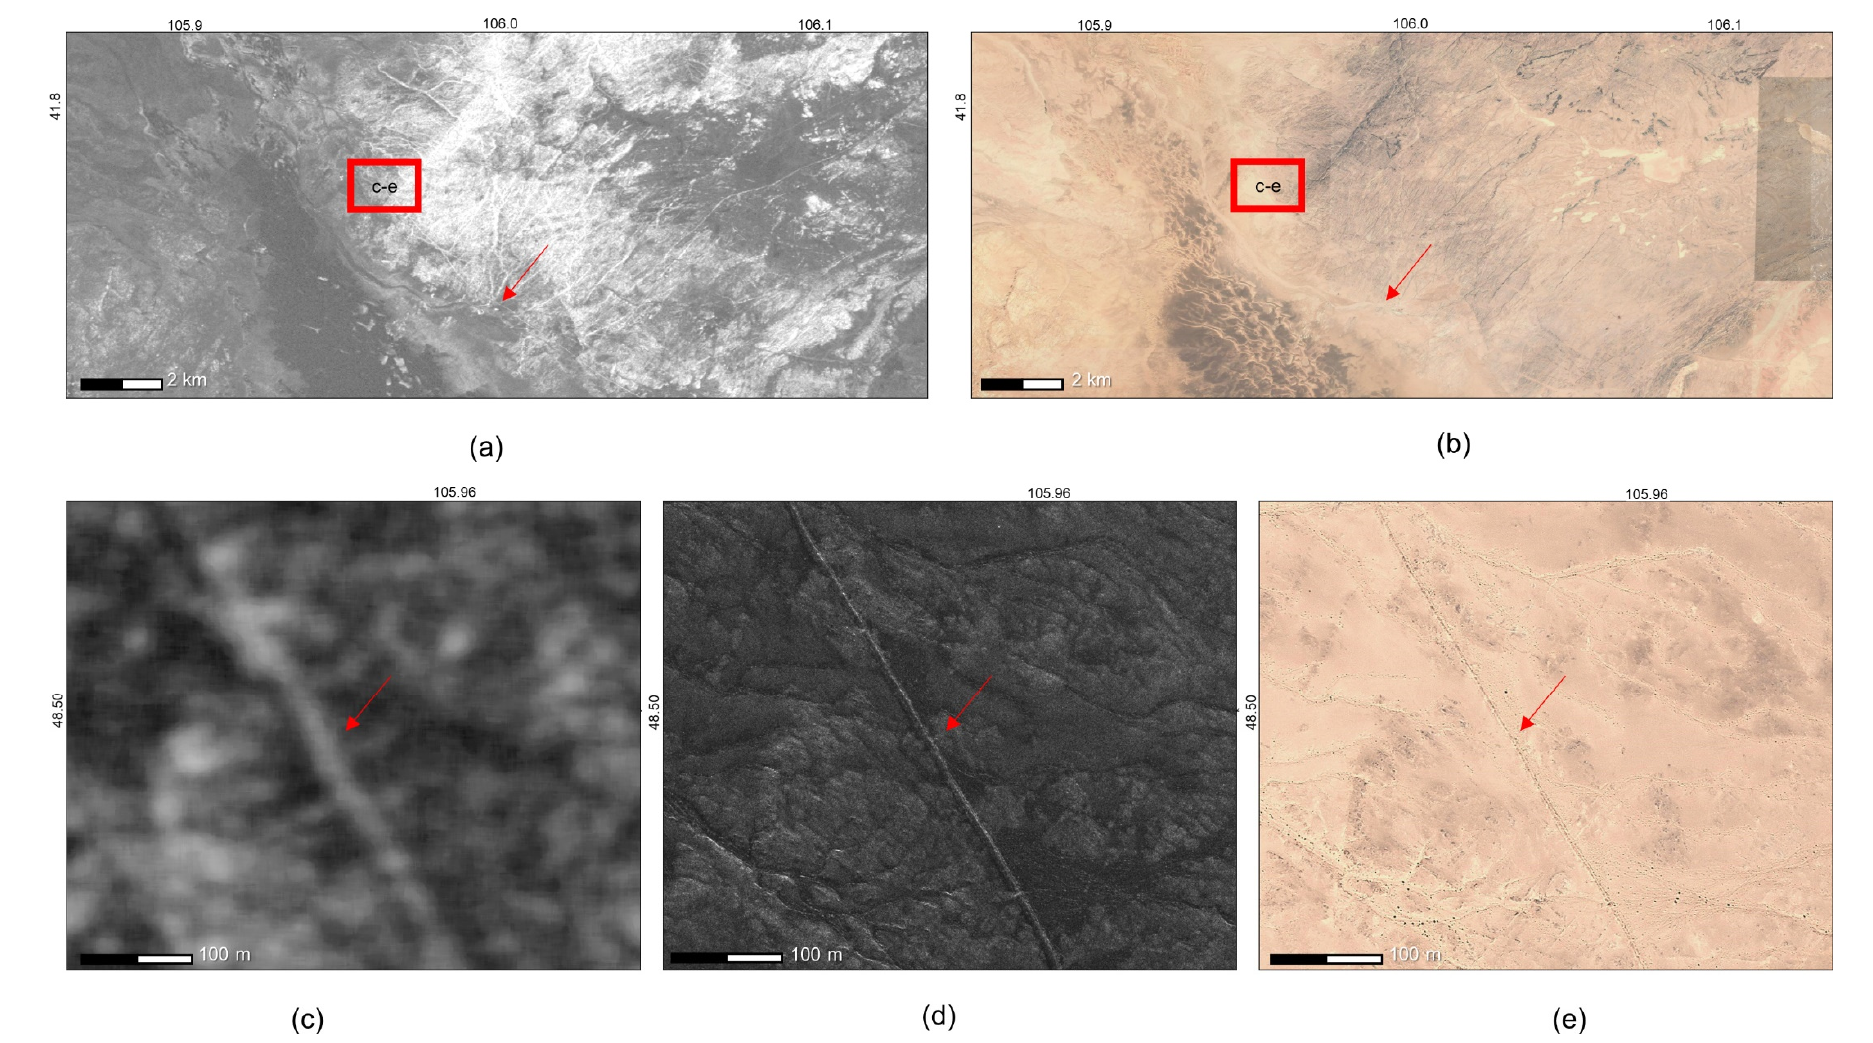
Figure 7. SAR imagery of the Gobi Desert: ( a ) Area 1, the Gobi Desert using Sentinel-1 C-band SAR imagery showing a faint outline of the MWS; ( b ) Google Earth imagery of the same extent; ( c ) Sentinel-1 C-band of wall line; ( d ) CAPELLA SAR imagery; ( e ) Google Earth imagery showing ambiguous line.